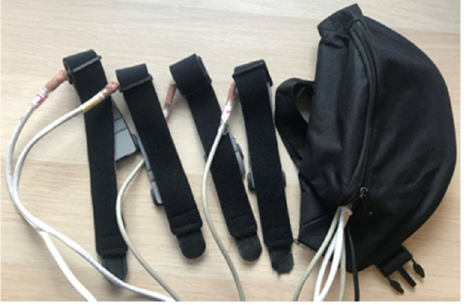
Figure 2. Equipment used for data collection during walking. Image of accelerometers in plastic casings, elastic straps, and microprocessor board housed in the waist bag for carrying during walking recordings.